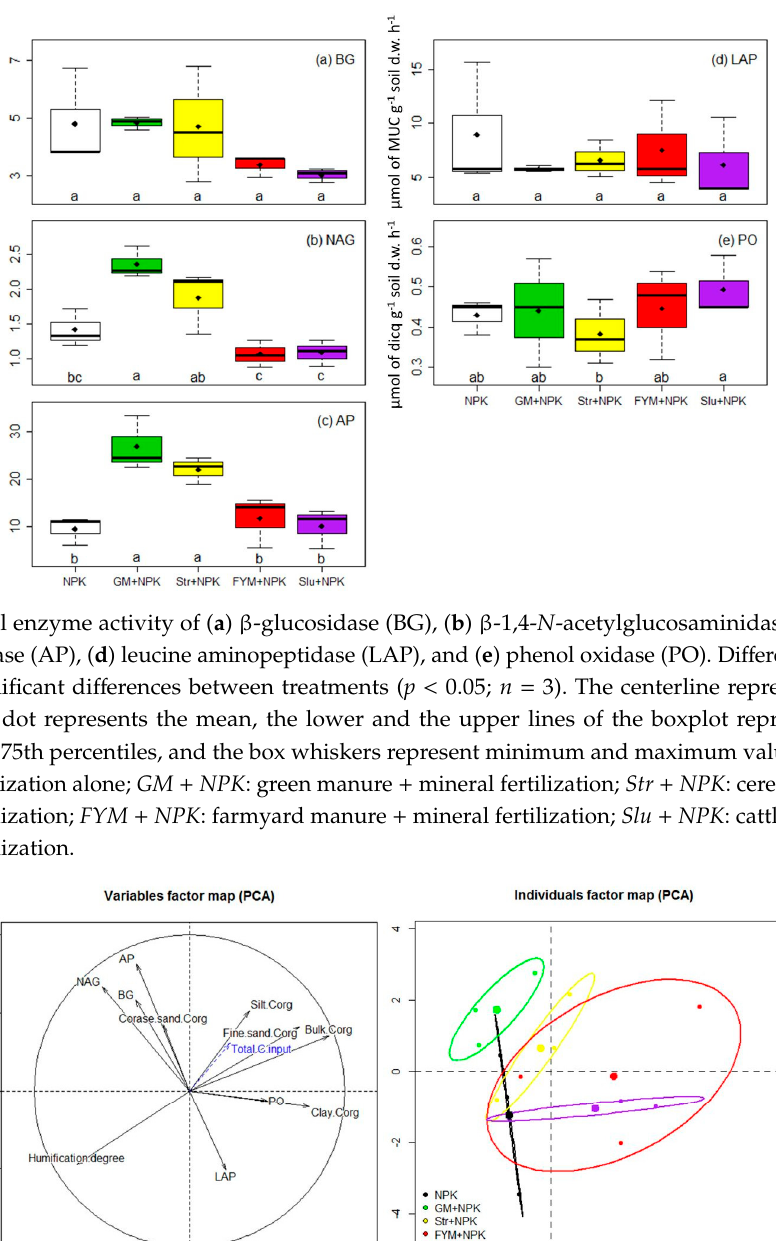
Figure 6. Principal component analysis (PCA) on both quantitative and qualitative parameters of the bulk soil with variables ( a ) and observations ( b ). The colored area indicates the 95% confidence ellipse of each treatment, with the centered dot indicating the mean and the smaller dots indicating the replicates ( n = 3). Variables: bulk soil Corg, humification degree of soil organic matter, Corg content (g · kg − 1 ) in the soil particle fractions (Corg coarse sand, Corg fine sand, Corg silt and Corg clay) and activity of enzymes (BG: β -glucosidase; NAG: β -1,4- N -acetylglucosaminidase; LAP: leucine aminopeptidase; AP: phosphatase; PO: phenol oxidase). Total fresh C input (total C input) was added as supplementary information that was not taken into account in the PCA analysis. NPK : mineral fertilization alone; GM + NPK : green manure + mineral fertilization; Str + NPK : cereal straw + mineral fertilization; FYM + NPK : farmyard manure + mineral fertilization; Slu + NPK : cattle slurry + mineral